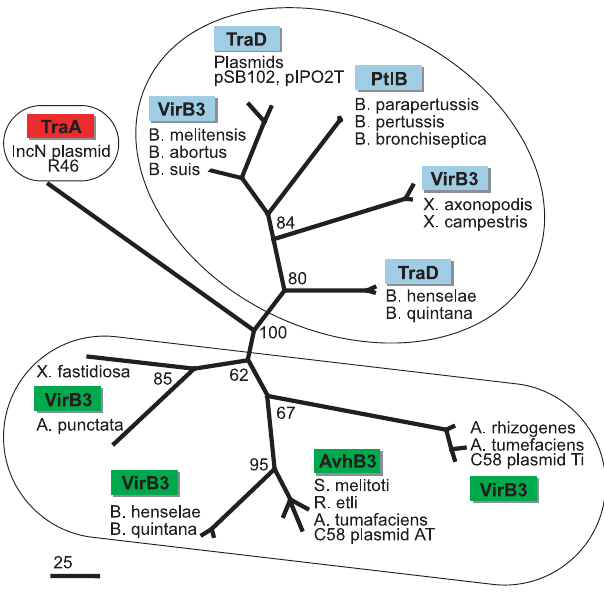
Figure 7. VirB3 PHN-Families Phylogeny The PHN-Families of nonconserved genes correlate with their molecular phylogeny. Shown here is the Maximum Likelihood tree of the 33 VIRB3 proteins classified in three PHN-Families (see Table S1). PHN-Families are enclosed in circles, color-coded as in Figure 8, and coincide with monophyletic branches of the phylogenetic tree. Numbers are bootstrap values, and the ruler shows the number of point-accepted mutations. doi:10.1371/journal.pcbi.